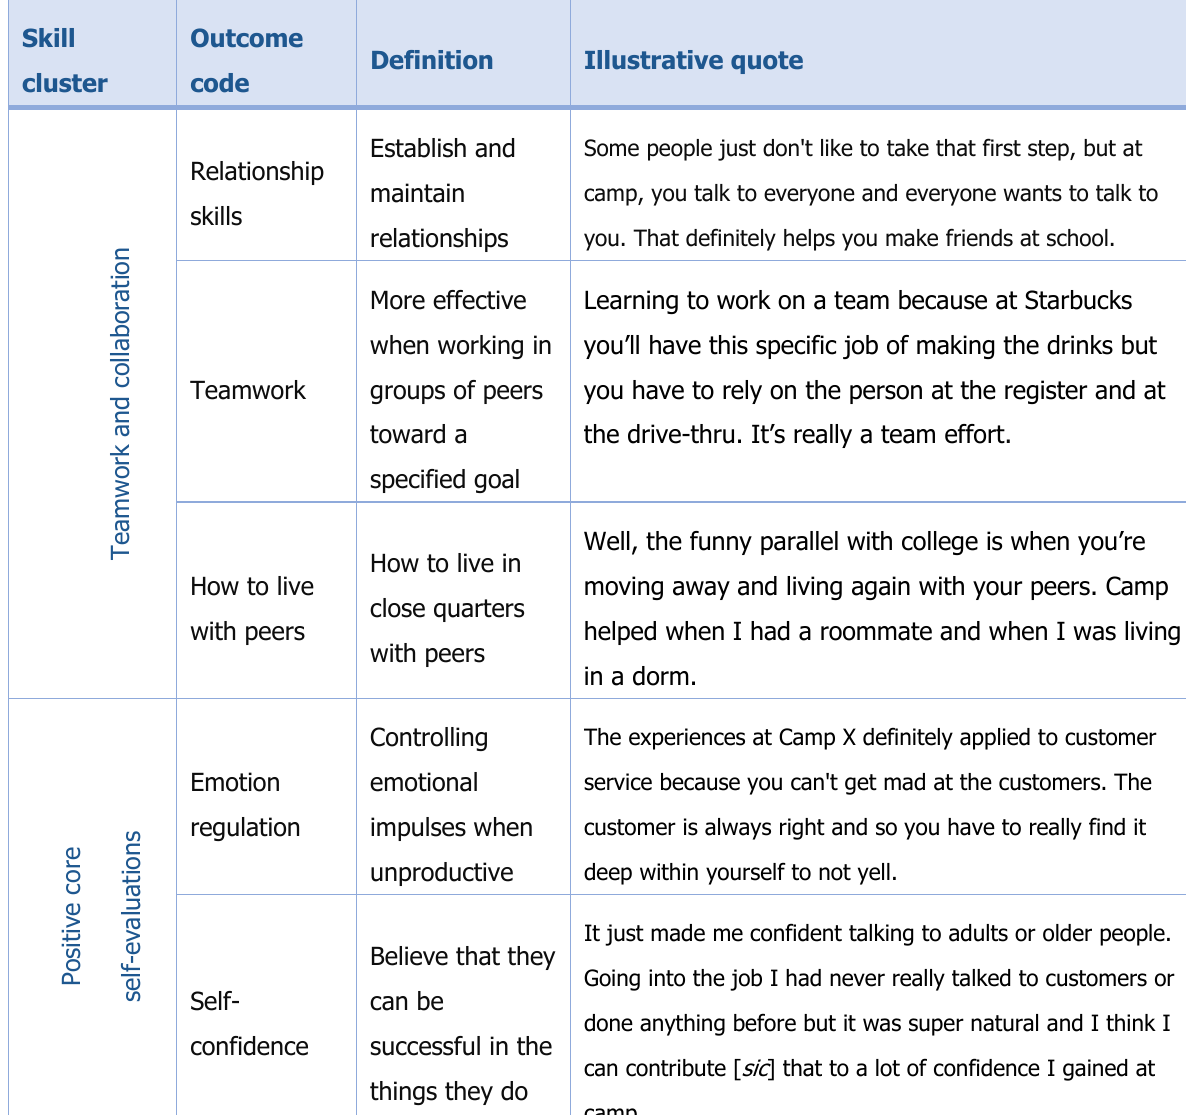
Table 3. Outcomes Identified as Central to Academic and Workplace Readiness Skill